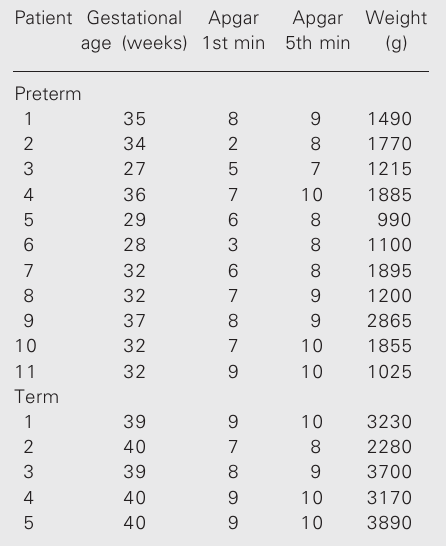
Table 1. Characteristic of term, and preterm in- fants who participated in the